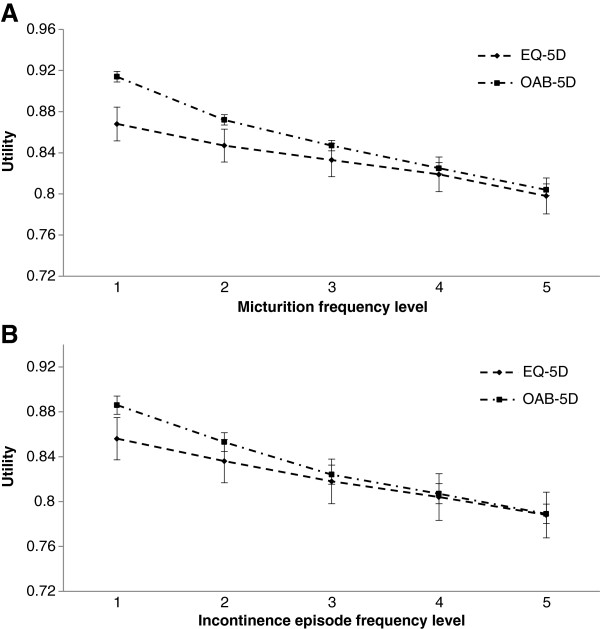
Adjusted utility estimates of EQ-5D and OAB-5D according to symptom frequency level. A–Adjusted utility estimates of EQ-5D and OAB-5D according to micturition frequency level; B–Adjusted utility estimates of EQ-5D and OAB-5D according to incontinence episode frequency level.